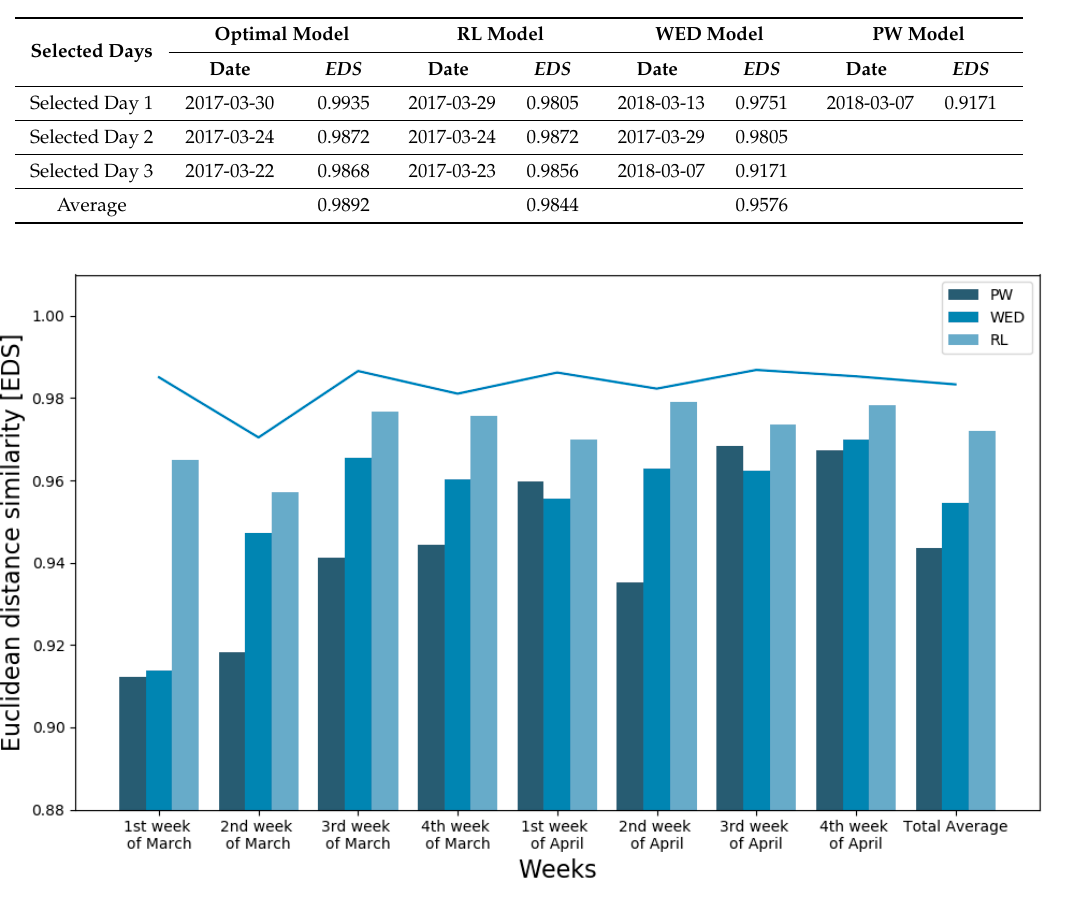
Figure 11. Similar day selection performance results for the models by day of week.